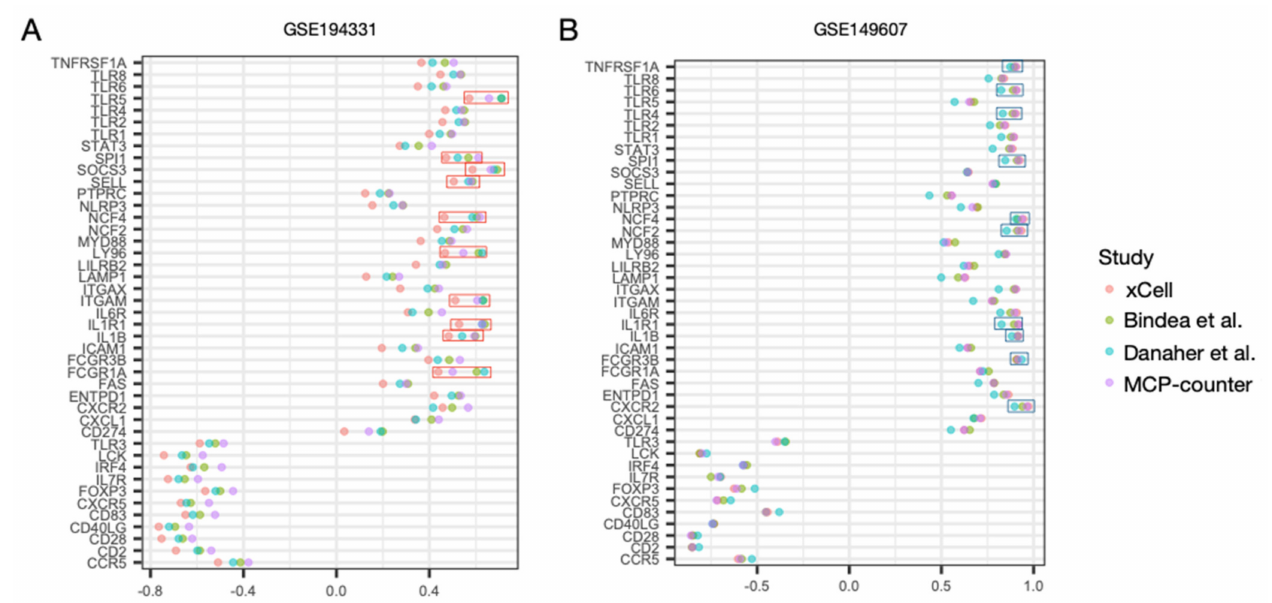
Figure 5. Correlation profiles of the hub genes. ( A , B ) Correlation coefficients calculated according to the four studies (xCell, Bindea et al., Danaher et al., and MCP-counter) between expression of the hub genes and their ssGSEA scores are plotted for GSE194331 and GSE149607. Due to higher variability between datasets, the top 10 genes with positive correlations are selected. Red boxes represent the top 10 genes with higher average correlation coefficients among the four studies in GSE194331. Blue boxes represent the top 10 genes with higher average correlation coefficients among the four studies